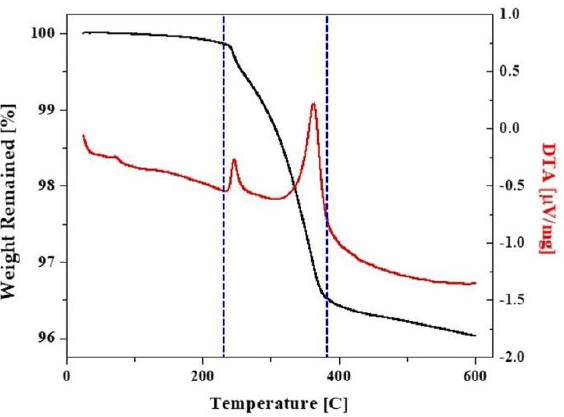
Figure 1. TG-DTA curve observed for as-received 5Y-PSZ granules as a function of temperature. The black and red lines represent TG and DTA results, respectively